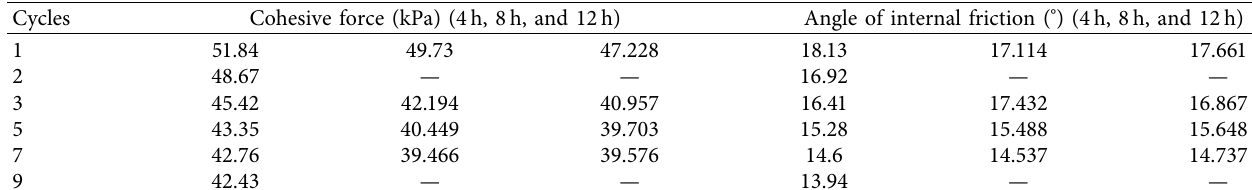
Figure 10: Relationship between c and φ parameters and different dry and wet cycles (8h and 12h). Table 5: Shear strength parameters under different dry and wet